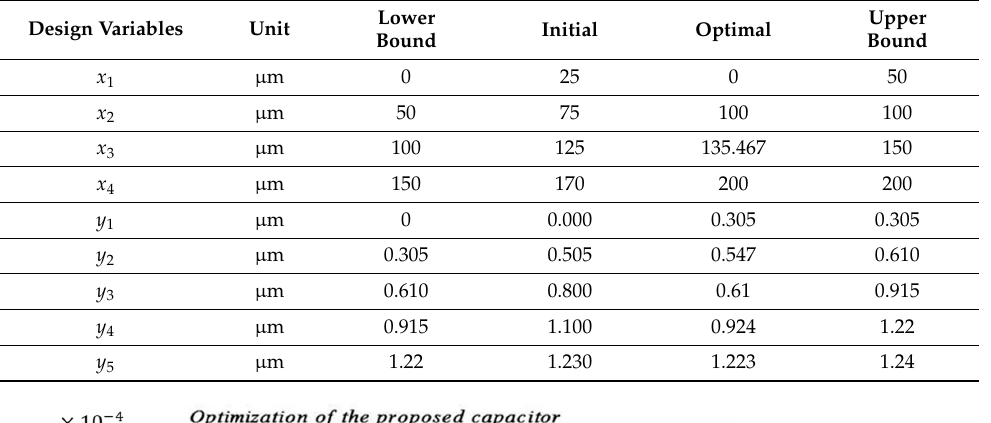
Table 2. Initial and optimal design variables values.